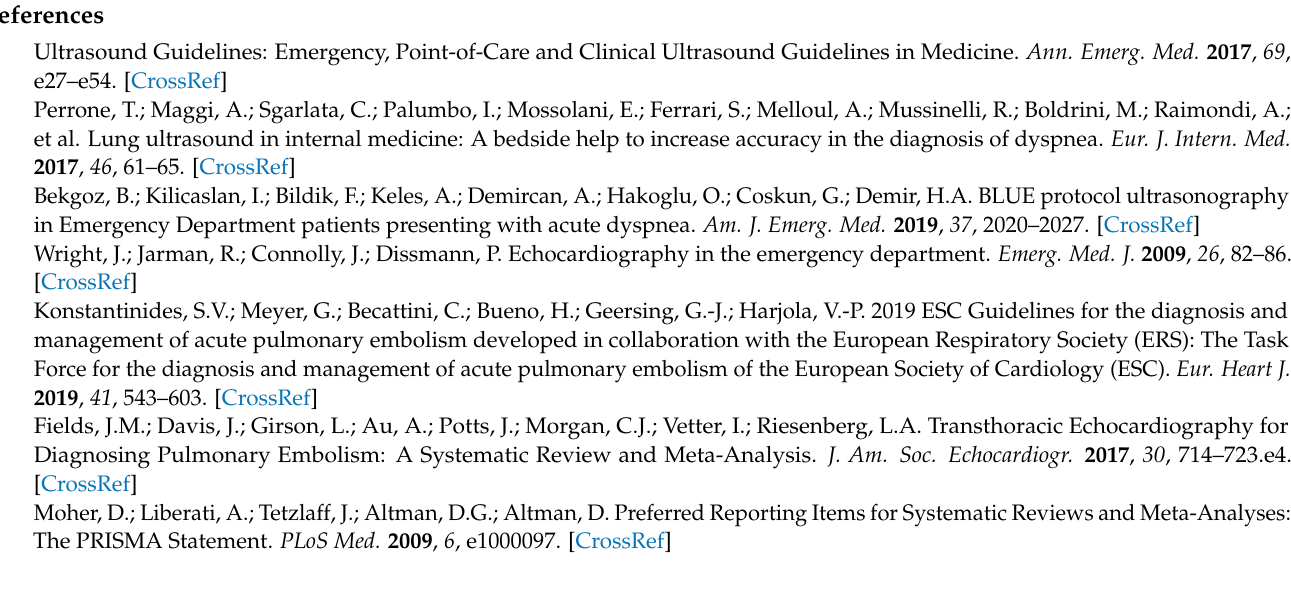
Table S2: Characteristics of the selected papers, Table S3: QUADAS-2 assessment table for the selected studies; Figure S3: HSROC model and Forest Plot for tricuspid regurgitant velocity; Figure S4: Fagan plots for tricuspid regurgitant velocity; Figure S5: HSROC model and Forest Plot for paradoxycal septum movement; Figure S6: Fagan plots for paradoxical septum movement; Figure S7: HSROC model and Forest Plot for right ventricle hypokinesis; Figure S8: Fagan plots for Right Ventricle